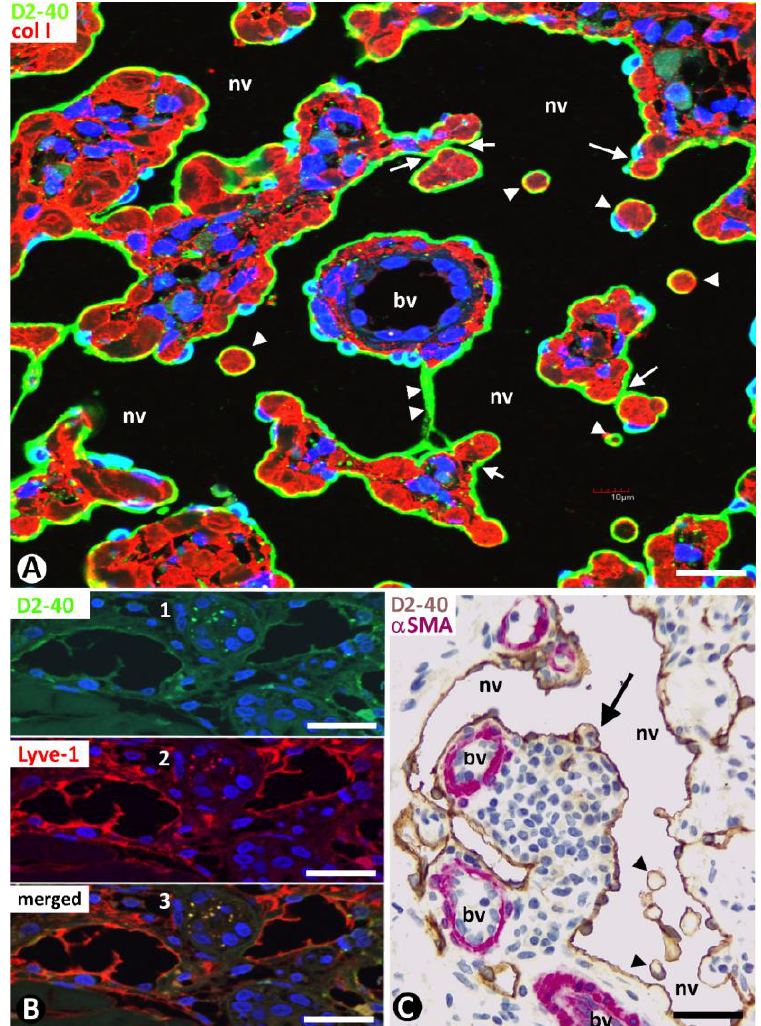
Figure 7. ( A ): Numerous pillars (arrowheads) and folds (thicker than pillars) in the wide lumen of a neovessel type 1 (nv) are observed by double immunofluorescence for D2-40 (green) and collagen I (red). Note that each pillar and fold shows a cover and a core. The covers are formed by D2-40+ ECs, and the cores present collagen I. An endothelial bridge or nascent pillar (double arrowhead) is observed between two folds. ( B ): D2-40 (1, green) and Lyve-1 (2, red) co-expression (3, merged) in neovessels. ( C ): Blood vessels (bv) in a fold with inflammatory cells and various pillars (arrowheads). ( A ): Double immunofluorescence for D2- 40 (green) and collagen I (red). DAPI counterstain. ( B ): Immunofluorescence for D2-40 (1, green), Lyve-1 (2, red), and merged (3). ( C ): Double immunochemistry for D2-40 (brown) and α SMA (red). Hematoxylin counterstain. Bar: ( A ): 25 µ m; ( B ): 35 µ m; ( C ): 50 µ